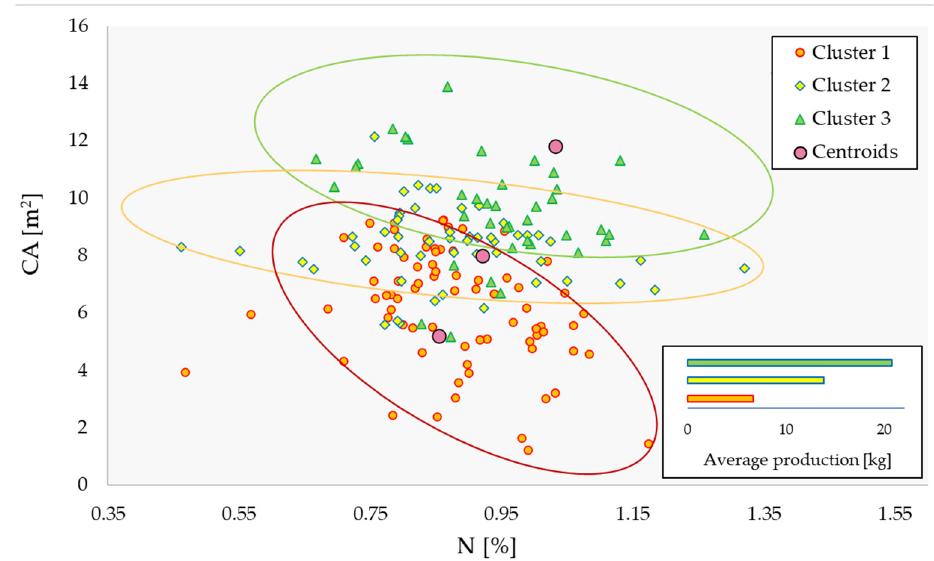
Figure 16. Cluster analysis of the three vigour groups (C1, C2, C3) according to total nitrogen con- tent and CA and ANOVA test results for the production. and CA and ANOVA test results for the